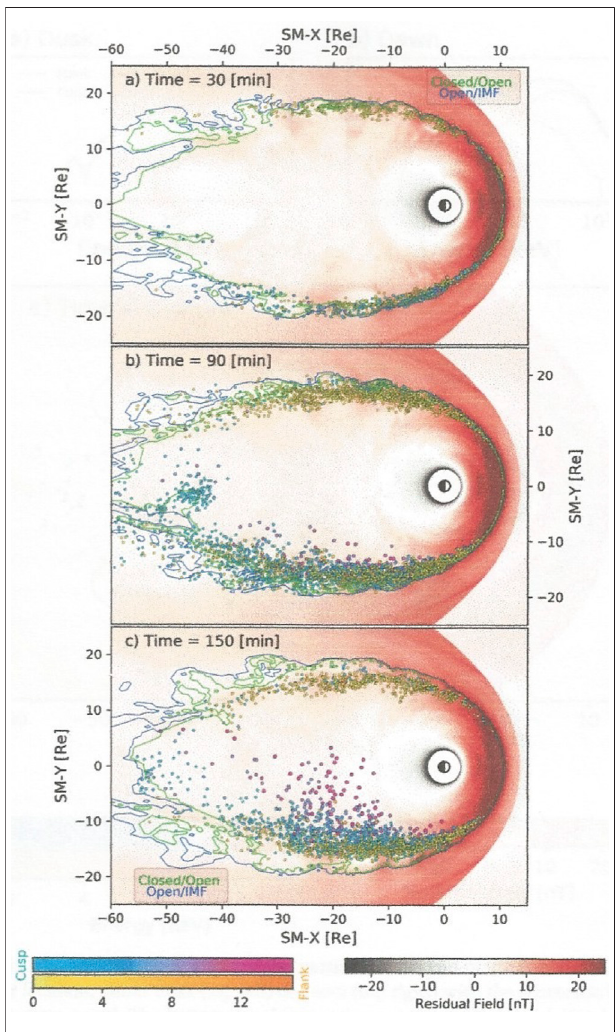
FIGURE11| Amodel(Sorathiaet al.,2019)showingthe fl owand timing of solar wind H+ from the bow shock to the fl anks of the magnetotail with subsequent diffusion toward the center of the